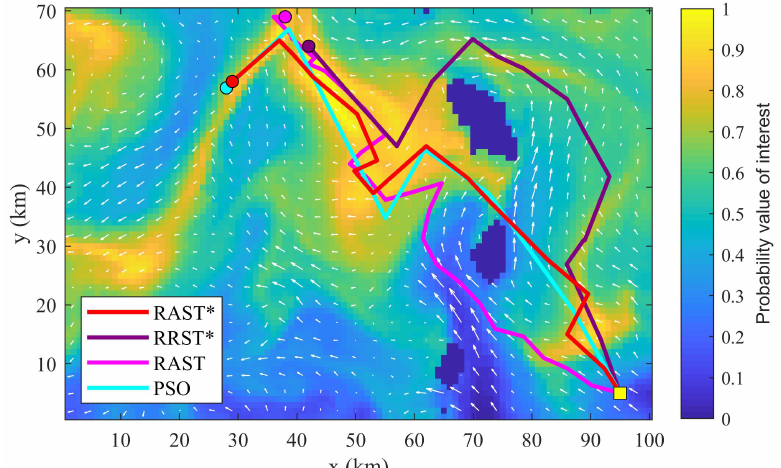
Figure 4. Illustration of optimized paths produced by RAST*, RRST*, RAST, and PSO over a scientific interest area with obstacles. (Scenario 2) The utility map denotes the probability value of scientific interest (blue = low scientific interest, yellow = high scientific interest, darkest blue = obstacles). White arrows represent ocean